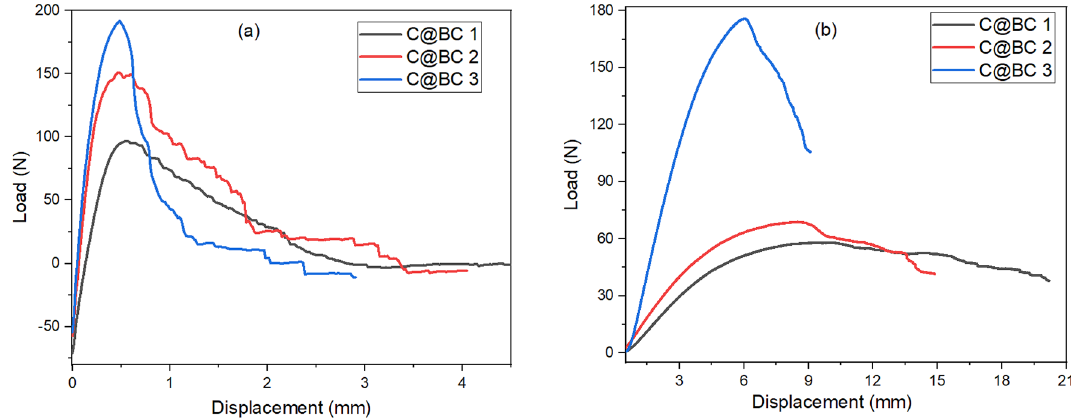
Figure 4. Load versus displacement curves for C@BC1, C@BC2, and C@BC3